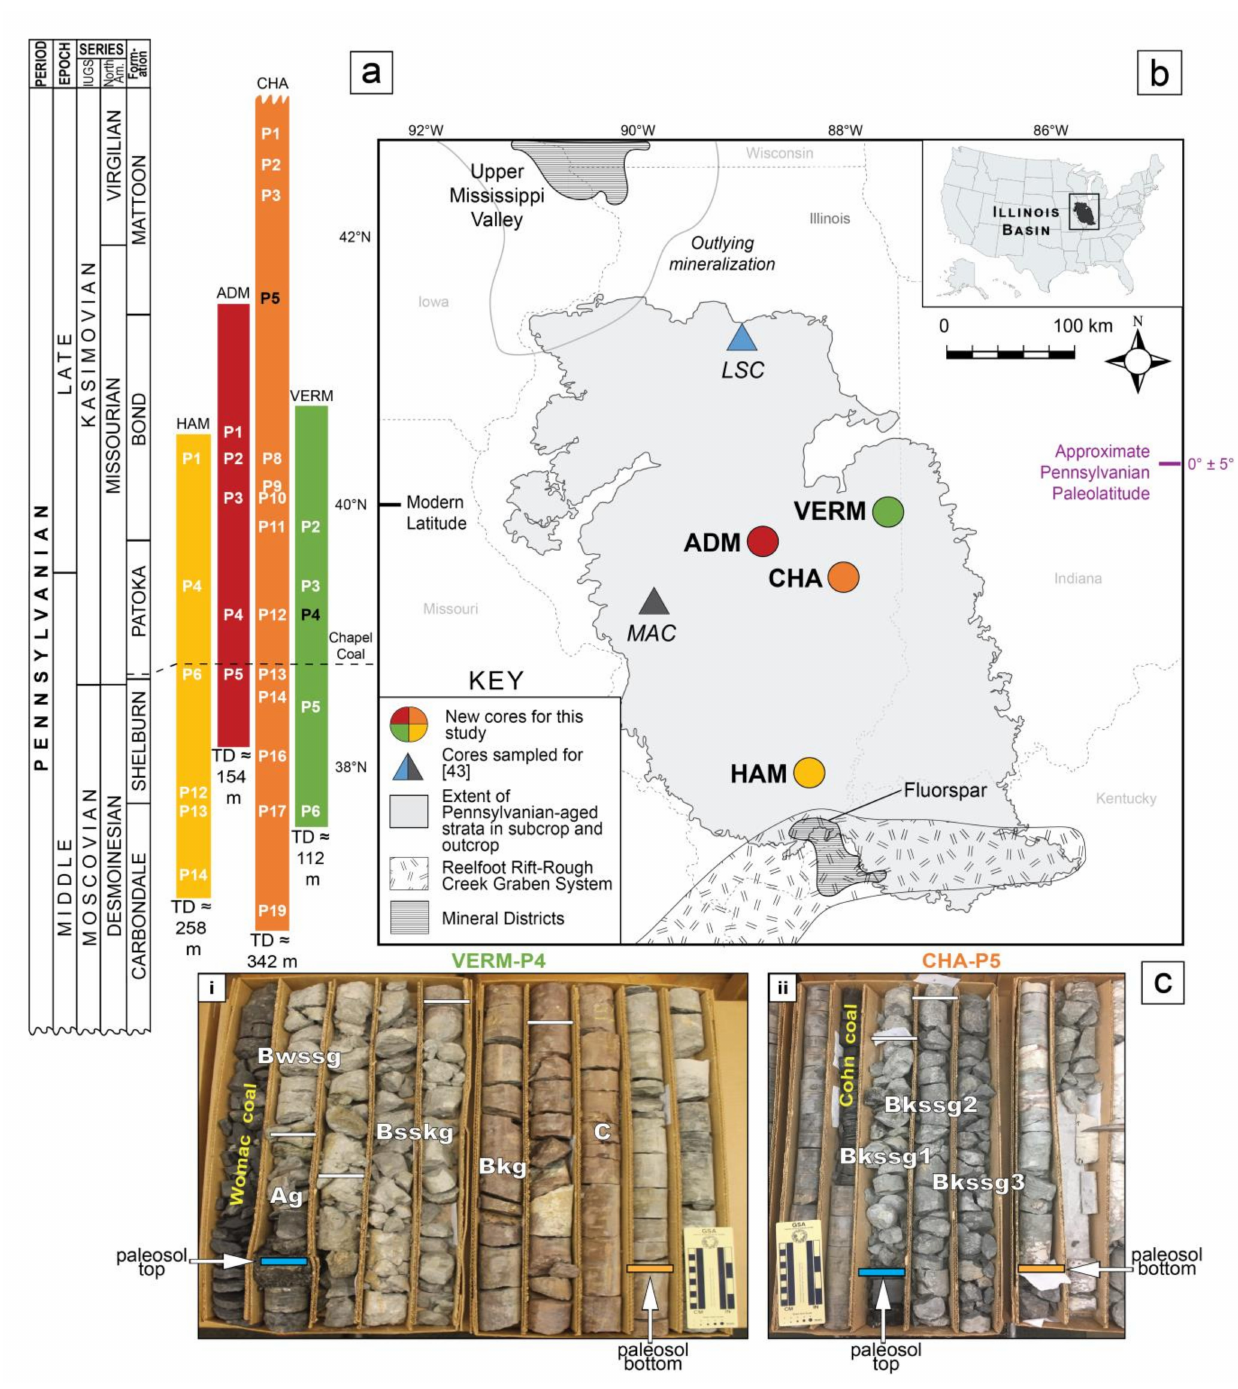
Figure 2. ( a ) Stratigraphic position of cores and paleosols identified in the Illinois Basin (IB) for this study. The cores include the Illinois State Geological Survey (ISGS) #1 City of Charleston (CHA), ISGS-Archer-Daniels-Midland, Borehole MMV-04B (ADM), the Materials Service Corps #F-72-8 (VERM), and the American Coal Company Borehole 7510-20 (HAM). P(#) notation indicates the paleosol identification number collected from the corresponding core, as well as its relative stratigraphic position (see Table 1). P(#)s denoted in black are depicted in Figure 2c herein. TD = total depth of the core from the surface, in meters. The Chapel Coal (dashed horizontal line) is delineated for reference. IUGS = nomenclature for geologic time terms reported by the International Union of Geological Sciences. North Am. = nomenclature for geologic time terms utilized in North America. ( b ) Map of the IB showing geographic locations of cores sampled for this study. Core locations represented by colored circles are the focus of methods, results, and discussion for this work. Core locations represented by colored triangles are sites studied in [43] (p. 607) that have complementary ∆ ◦ 2 θ data incorporated into the discussion of this work (data on Reichweite Ordering from the Lone Star Cement Company #TH-1 (LSC) and Monterey